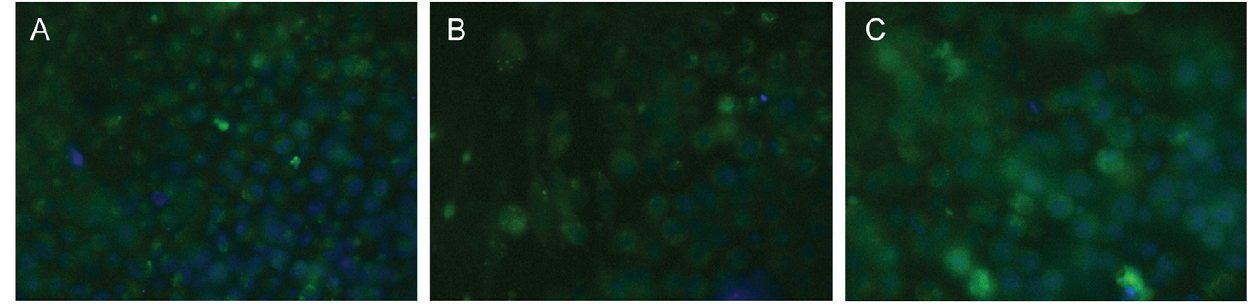
Figure 4. FluoZin-3 staining is unchanged with induction of differentiation. FluoZin-3 is green, Hoechst 33342 is blue. A. Control H9 cells. B. RA treated cells. C. Activin A treated cells. All images are representative of roughly 20 fields of view from three experimental